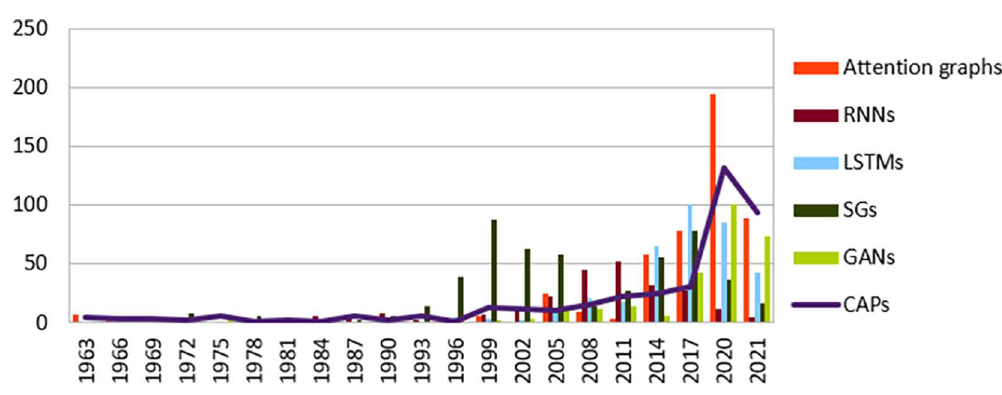
Fig 7. DNNs models distribution over years as a graph based solution to CAPs.